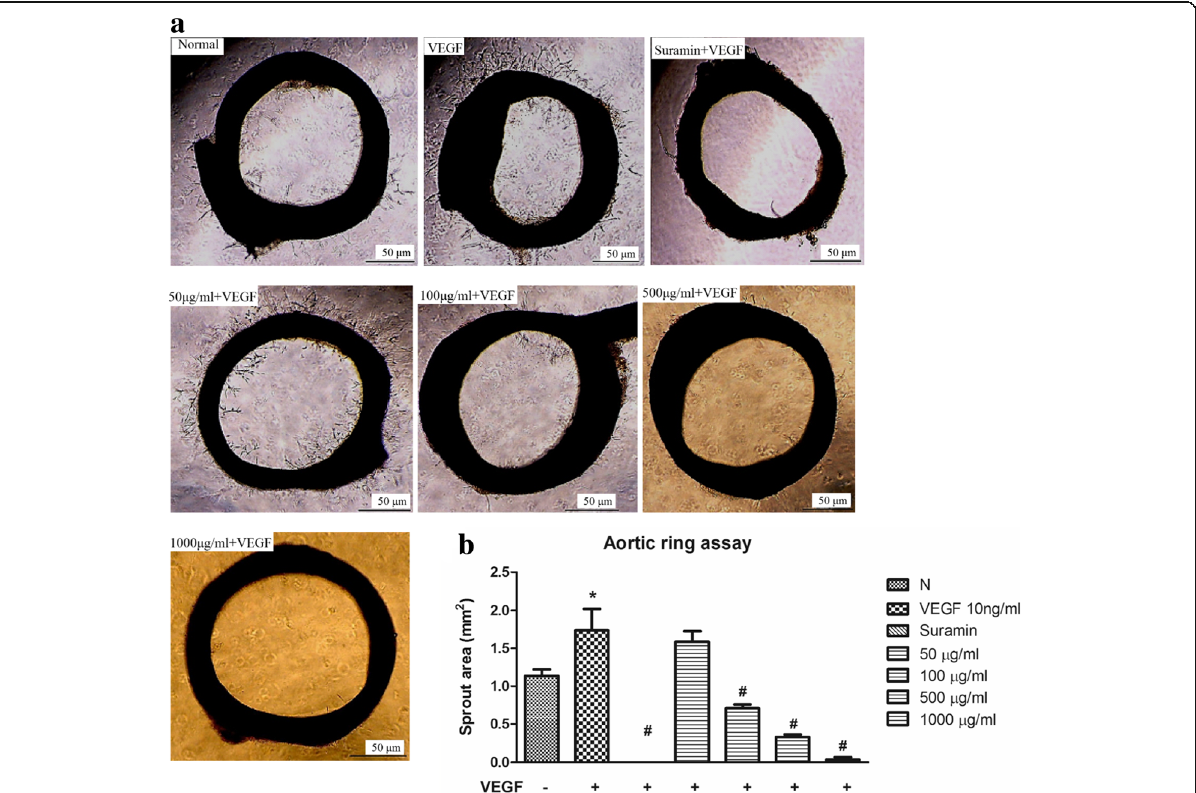
Fig. 8 Effect of C. nutans leaf extract on VEGF-induced microvessel sprouting of rat aortic ring. Suramin at a dose of 50 μ M was used as a positive control. a C. nutans water extract inhibited vessel sprouting in rat aorta ring induced by VEGF. Representative results were shown. b The sprout length was quantified. The values presented are the mean ± SEM of three independent experiments. * p < 0.05 were considered significant when compared to normal control (N); # p < 0.05 were considered significant when compared to VEGF alone group. ( n =